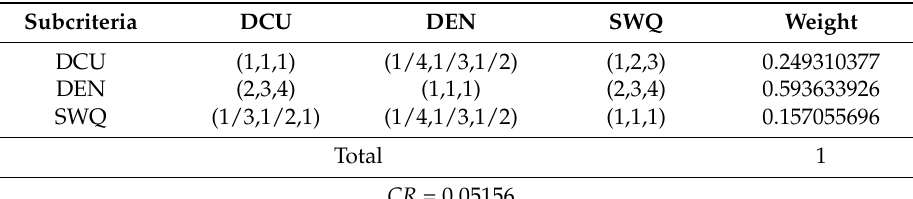
Table A12. Comparison matrix for DLT.